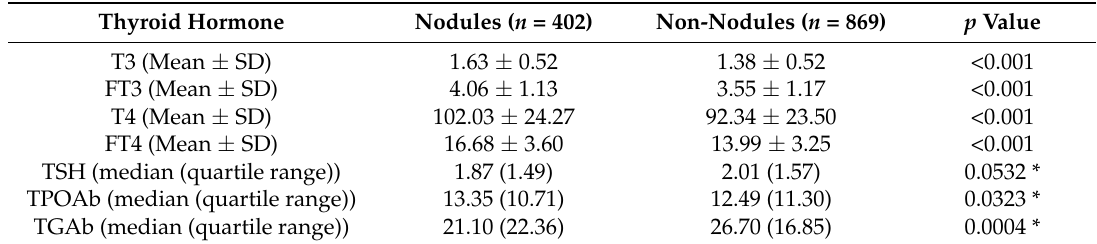
Table 2. The characteristics of thyroid hormone among patients with and without thyroid nodules.